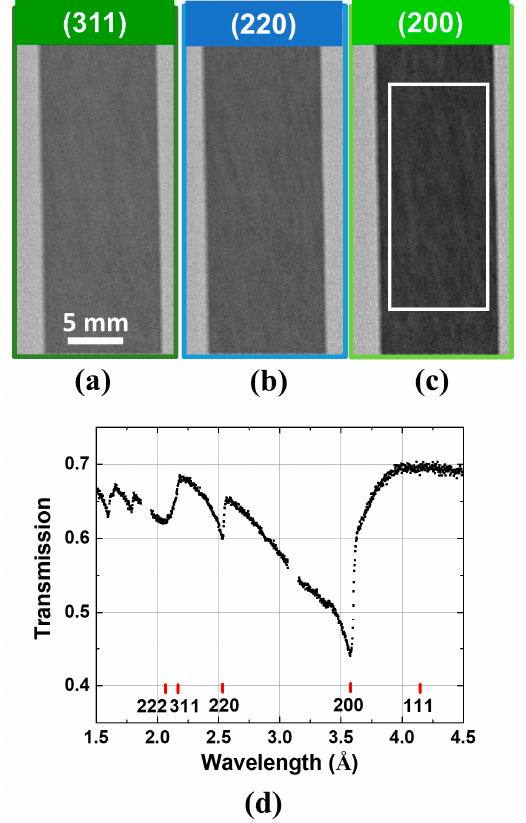
Figure 5. Transmission radiographs obtained at the narrow range of wavelength near the ( a ) (311), ( b ) (220), and ( c ) (200) Bragg edges and ( d ) transmission spectrum combined from all the pixels within the white rectangle in ( c ) for the single Col. sample before loading (15 MPa: reference loading).